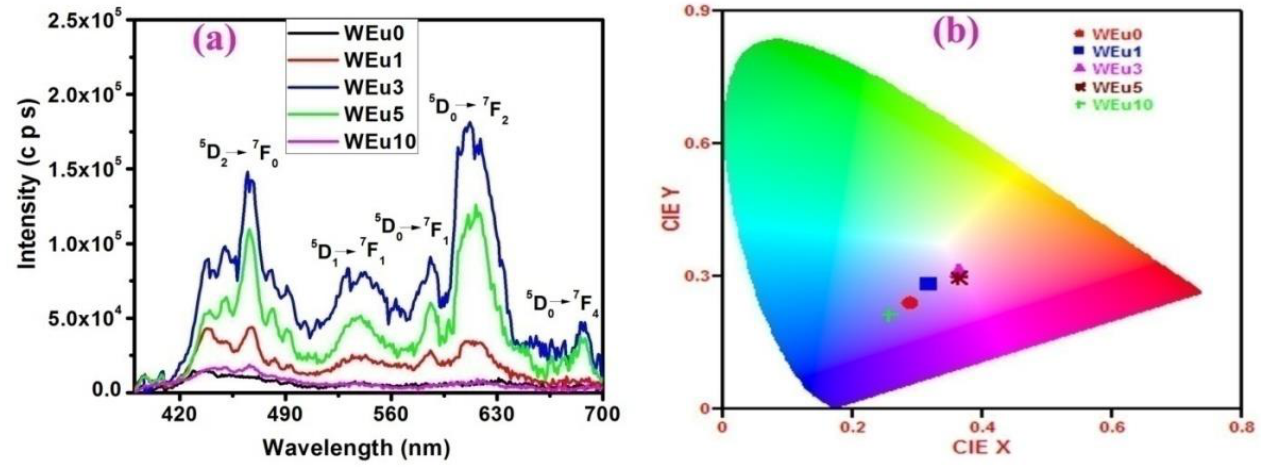
Figure 12. ( a ) PL emission spectra and ( b ) CIE chromaticity plot of the un-doped and Eu 3+ -embedded WO 3 films annealed at 600 °C.